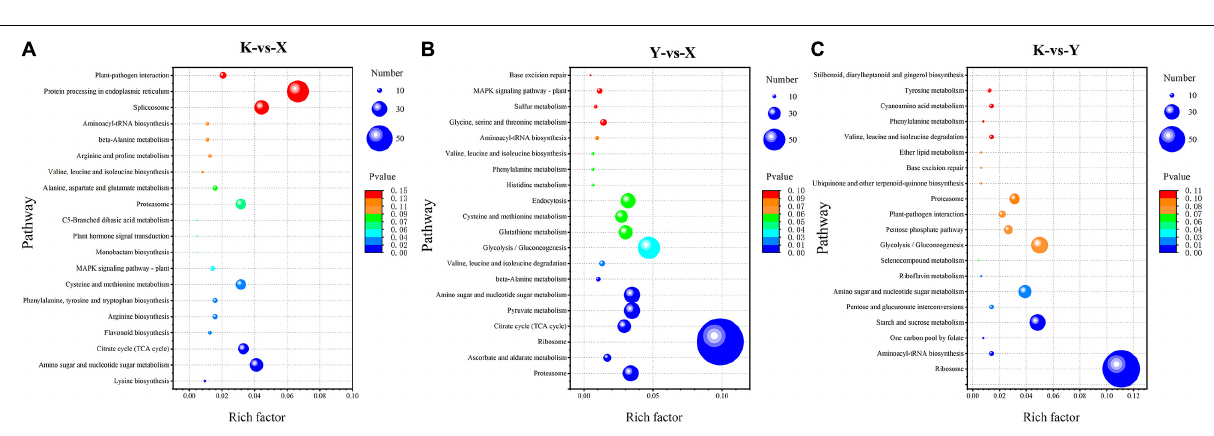
( Figure 7B ). Moreover, the significantly enriched pathways in shade-drying vs. smoke-drying were ribosome, aminoacyl- tRNA biosynthesis, one-carbon pool by folate, starch and sucrose metabolism, pentose and glucuronate interconversions,